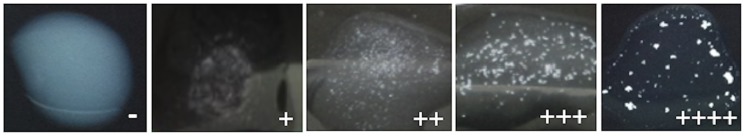
Typical of agglutination latex assay: negative and a semi-quantitative positive (from + to ++++) agglutination pattern with anti-EspB MAb coated beads.The test control with lysis buffer (B-PER) showed the same pattern as LEE-negative isolates.